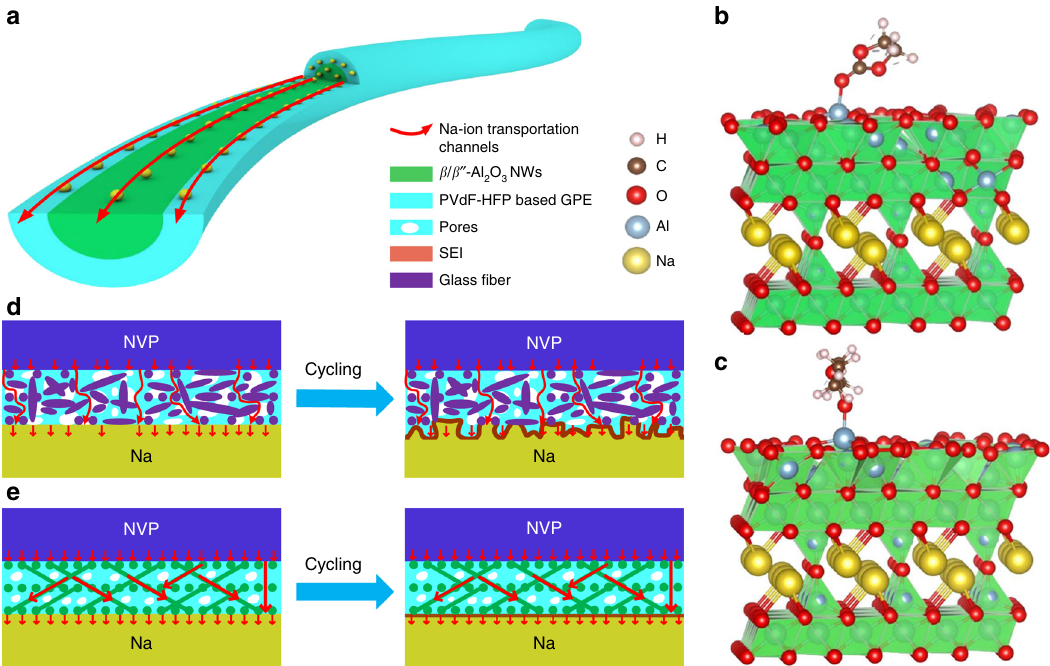
Fig. 1 Schematic of NVP/Na batteries using ANs – GPE and GFs-GPE electrolytes. a Structure and Na-ion transportation mechanism of ANs – GPE. b , c Adsorption of ethylene carbonate (EC) and diethyl carbonate (DEC) on β ″ -Al 2 O 3 (003). d , e Working mechanism of NVP/Na batteries during long cycles with GFs-GPE and ANs – GPE. In the NVP/ANs – GPE/Na batteries, the fl at ANs – GPE creates dense, uniform and solid – liquid hybrid Na-ion transportation channels on the surface of the Na metal anode that contribute to uniform Na deposition and the formation of stable and smooth SEI fi lms during long cycles, while in the NVP/GFs-GPE/Na batteries, uneven Na deposition occurs due to the nonionic conductive GFs and highly porous structure of